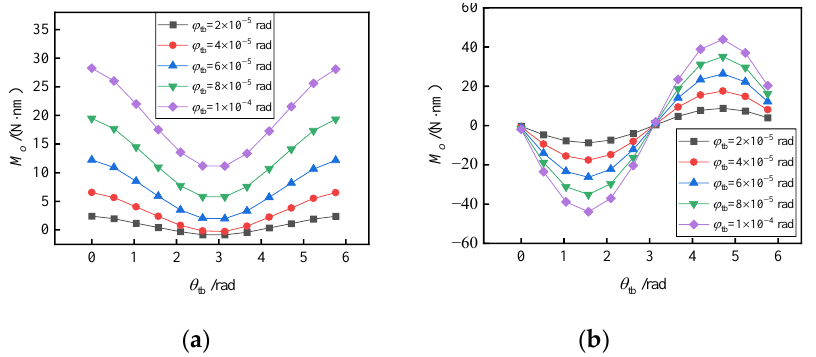
Figure 18. Interference torque versus the angular deviation of the axis. ( a ) with f = (10 0 0) m/s 2 . ( b ) with f = (0 0 10) m/s 2